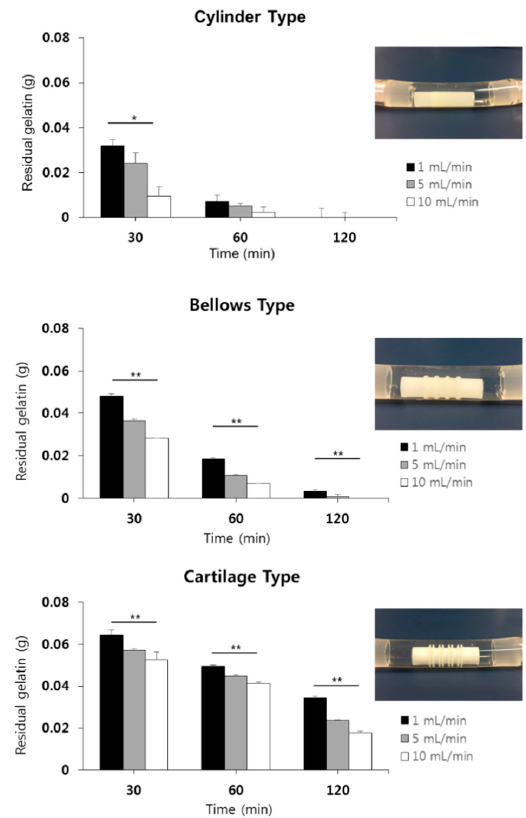
Figure 11. Measurement of residual hydrogel on trachea scaffolds using circulation system. (* p < 0.05, ** p <